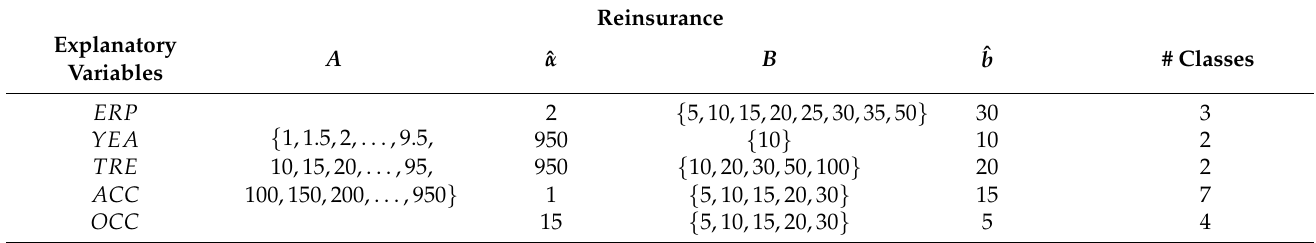
Table A5. Parameters of the evtree for reinsurance undertakings.